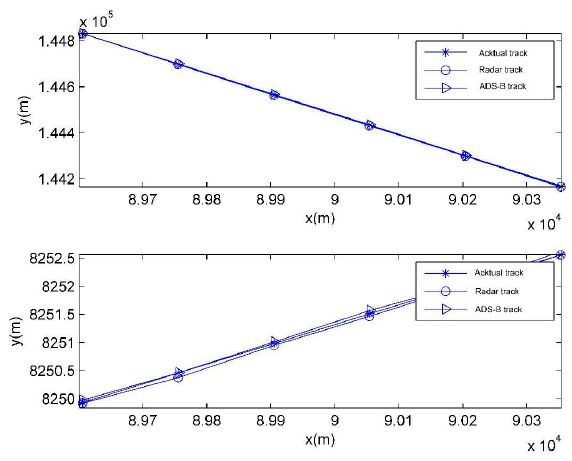
Figure 7. Observed track and actual track.